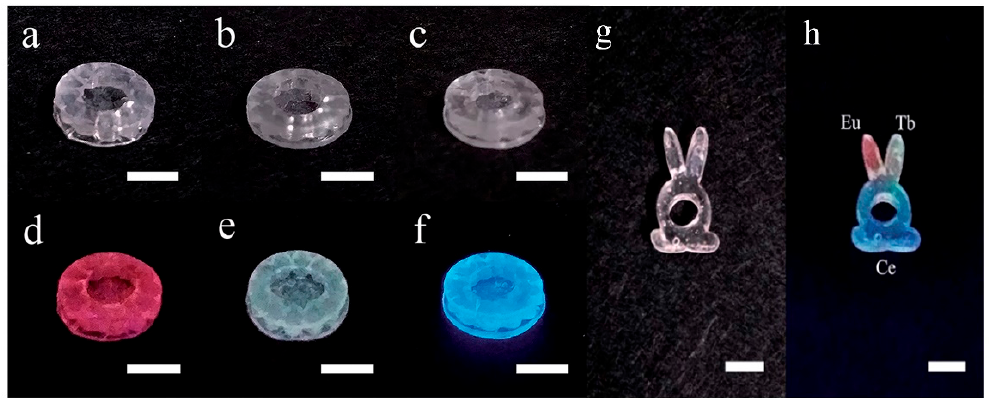
Figure 2. Photos of the 3D-printed silica glass doped with ( a ) Eu 3+ , ( b ) Tb 3+ , and ( c ) Ce 3+ ions, and their luminescent performance under a 254 nm UV lamp are shown in ( d – f ). Photos of selected-area- doped silica glass under ( g ) natural light and ( h ) 254 nm UV radiation. Scale bar: 5 mm [75].